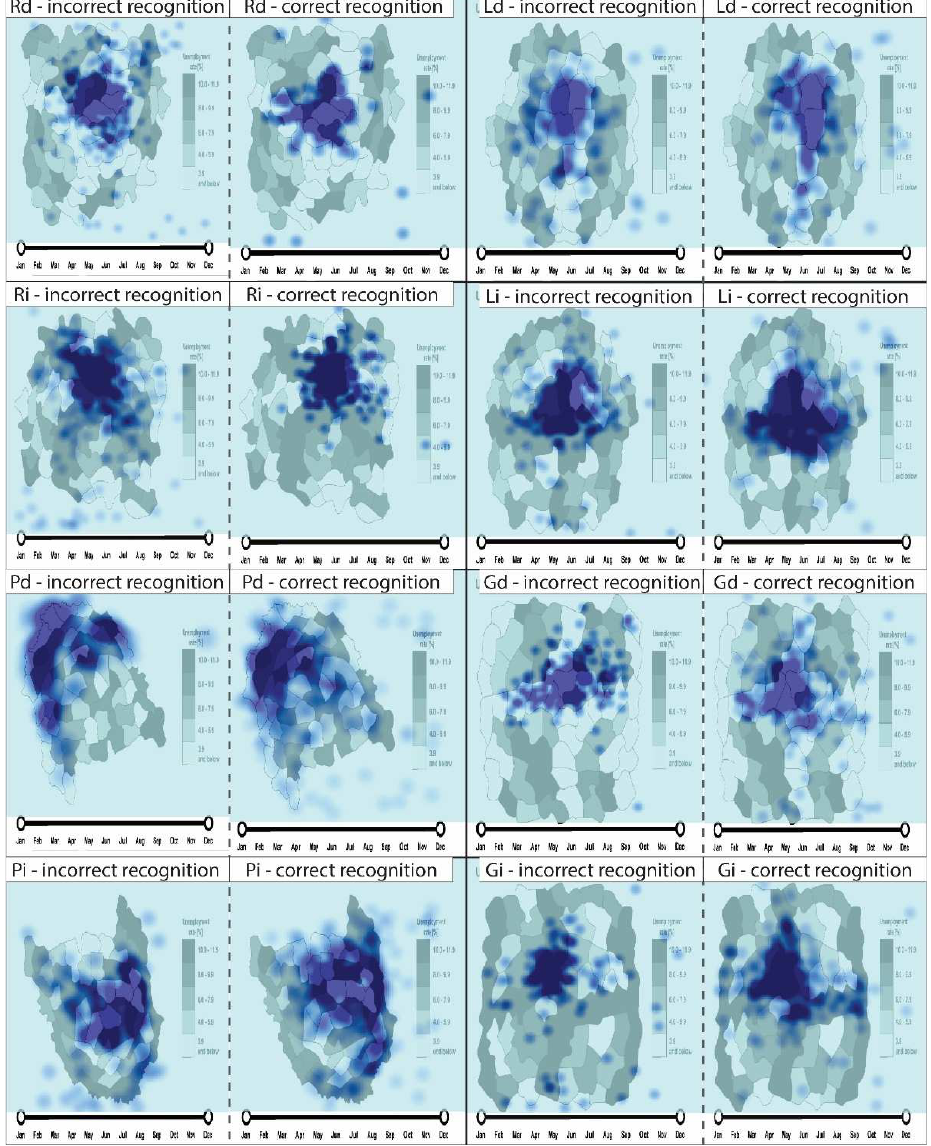
Figure 6. Fixation density clusters for correct and incorrect recognition of spatial patterns and temporal trends.